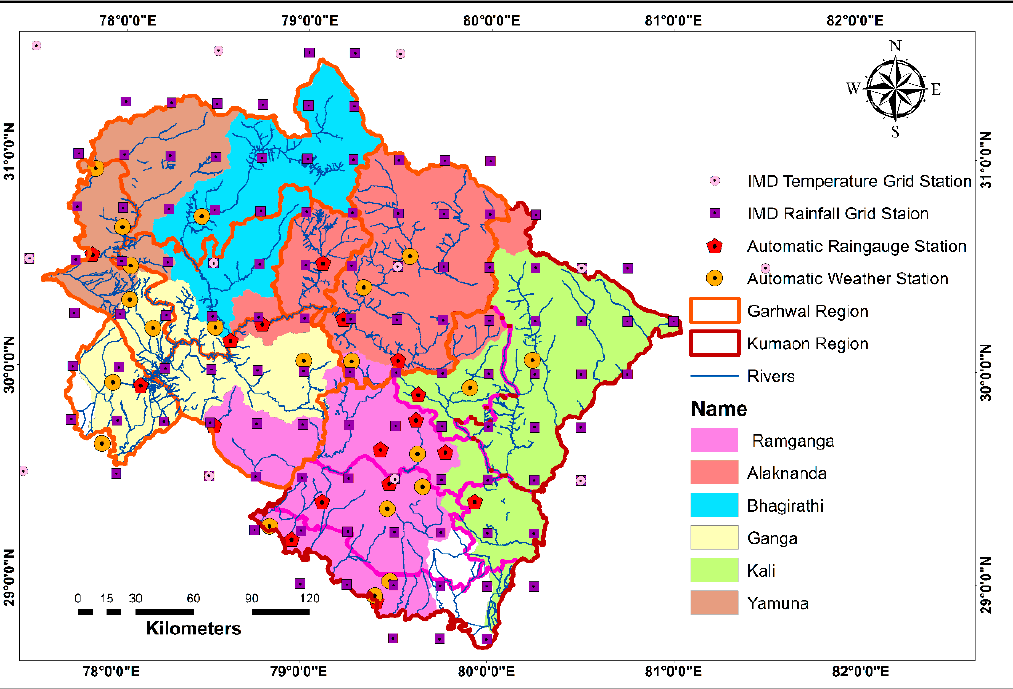
Figure 2. The spatial distribution of IMD-ARG and IMD-AWG along with the major river basins in the state of Uttarakhand.